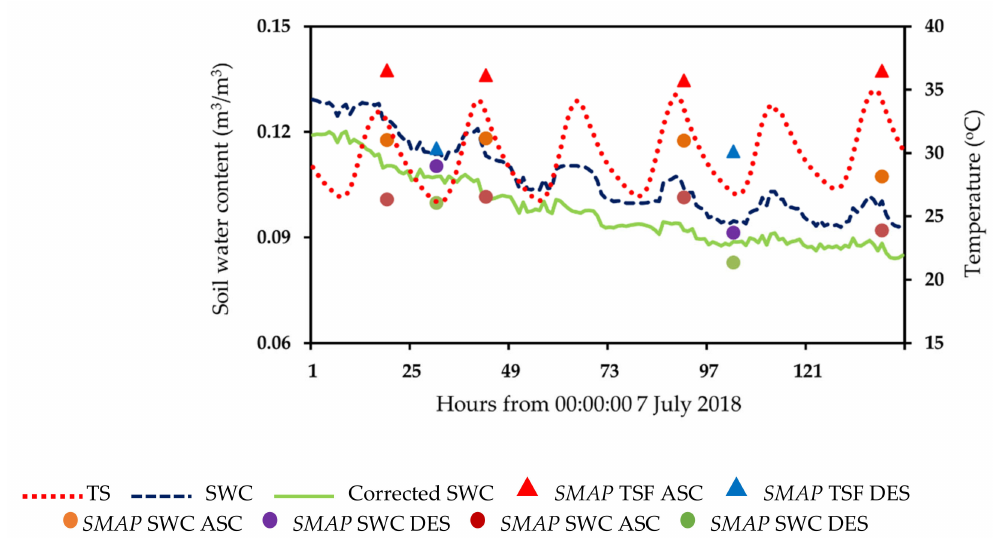
Figure 7. The soil temperature, SWC, and corrected SWC in hourly intervals and the SMAP SWC and corrected SMAP SWC at ASC and DES nodes at the LWREW. The red dotted, blue dashed, and solid light green lines represent the soil temperature, SWC, and corrected SWC at 5-centimeter depth, respectively. The red and blue triangles stand for the SMAP surface temperature at ascending and descending nodes, respectively. The orange and purple dots perform the SMAP SWC at ascending and descending nodes, respectively. Finally, the wine-red and green dots denote the corrected SMAP SWC at ascending and descending nodes,